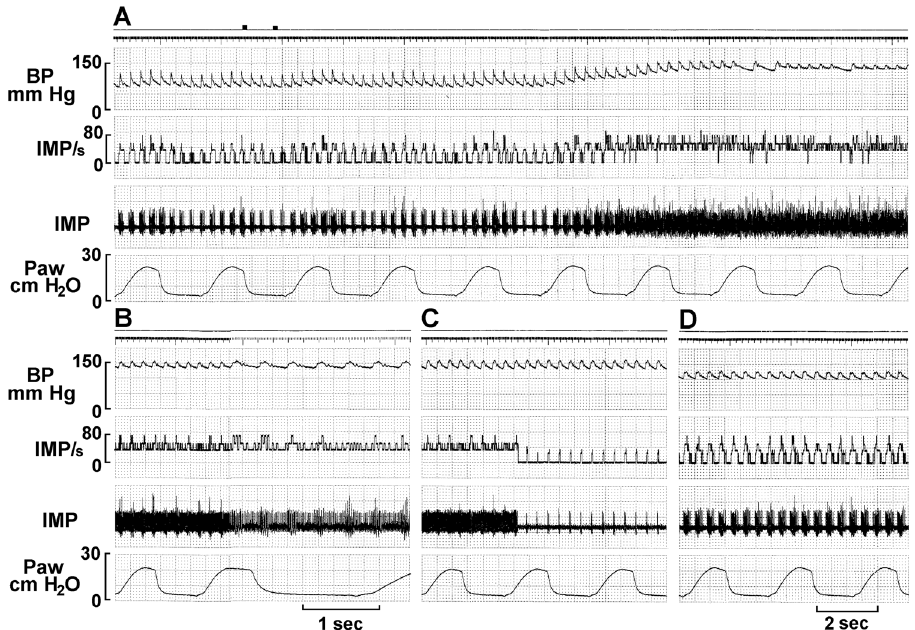
Figure 8. Unit activity of aortic baroreceptors in an anesthetized rabbit. The traces from top to bottom are: arterial blood pressure, impulse activity per second, impulse activity, and airway pressure. The time elapsed between A and B, B and C, and C and D were 50 s, 50 s, and 430 s respectively. The two black markers on the top of figure A indicate injection of a vasopressor (phenylephrine). Please note the baroreceptor activity increases as arterial blood pressure increases following the injection of the vasopressor (A). The unit discharged at higher frequency continuously until 129 s after the injection. Then the activity abruptly decreases (C); it is still discharging in phase with cardiac rhythm. Please note that the discharge frequency is low even though the blood pressure stays high around 150 mmHg. The decreased activity is due to pacemaker switching, indicating that a single baroreceptor unit possesses multiple encoders. The discharge pattern returned to normal 420 s after the pacemaker switching